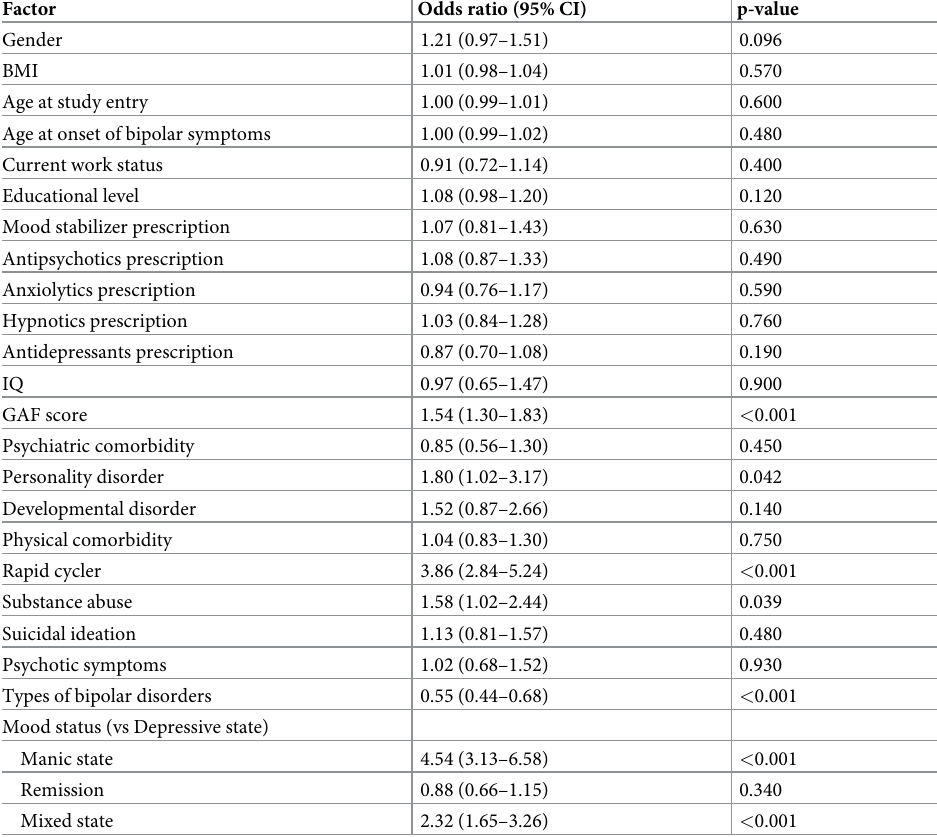
Table 2. Binomial logistic regression analysis of baseline factors for manic/hypomanic episodes during the year after